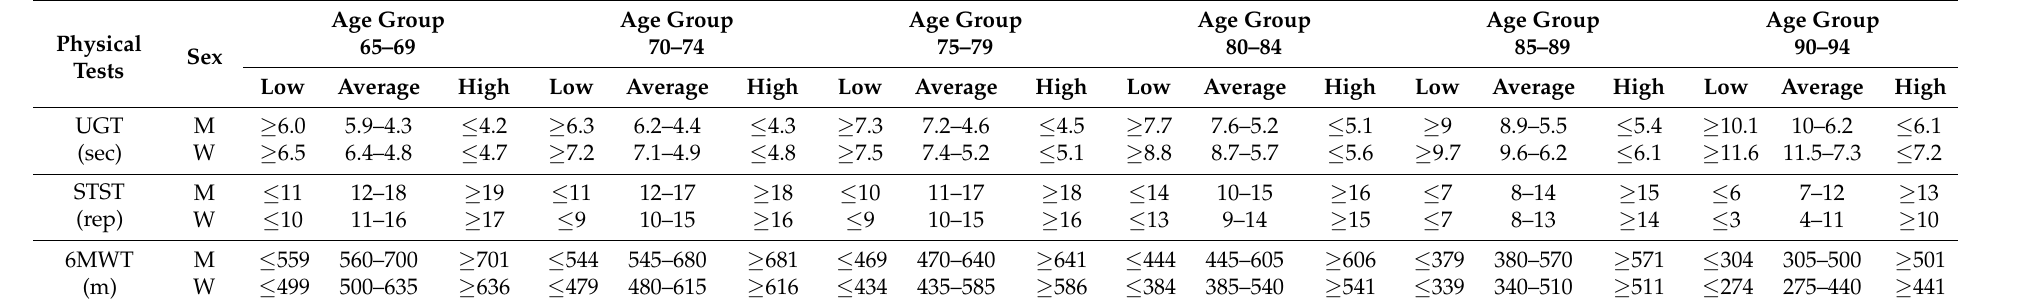
Table 1. Classification by fitness